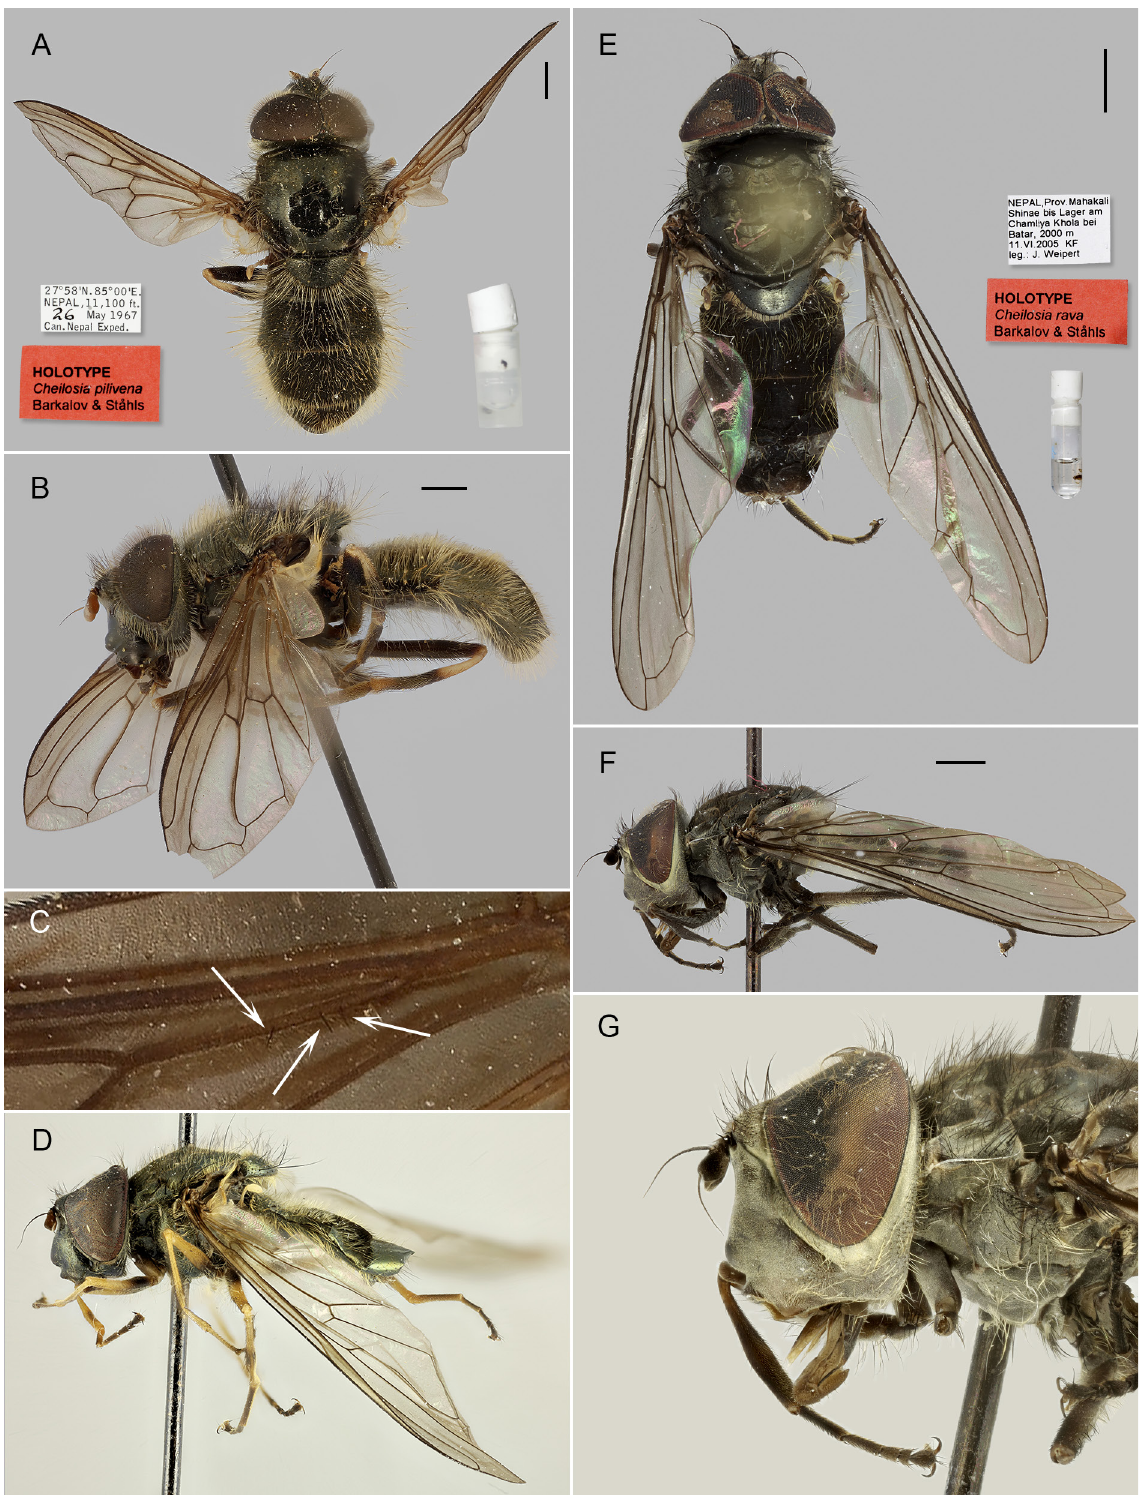
Fig. 53. A–C . Cheilosia ( Cheilosia ) pilivena sp. nov., holotype, ♂ (CNC). A–B . Habitus, dorsal and lateral views, C . Wing, vein Rs with pile (indicated by white arrows). – D . Cheilosia ( Pollinocheila ) quinta Barkalov & Cheng (IBSJW/NME); lateral view. – E–G . Cheilosia ( Pollinocheila ) rava sp. nov., holotype, ♂ (IBSJW/NME); dorsal and lateral views. Photo: Pekka Malinen, FMNH Luomus. Scale bars = 1